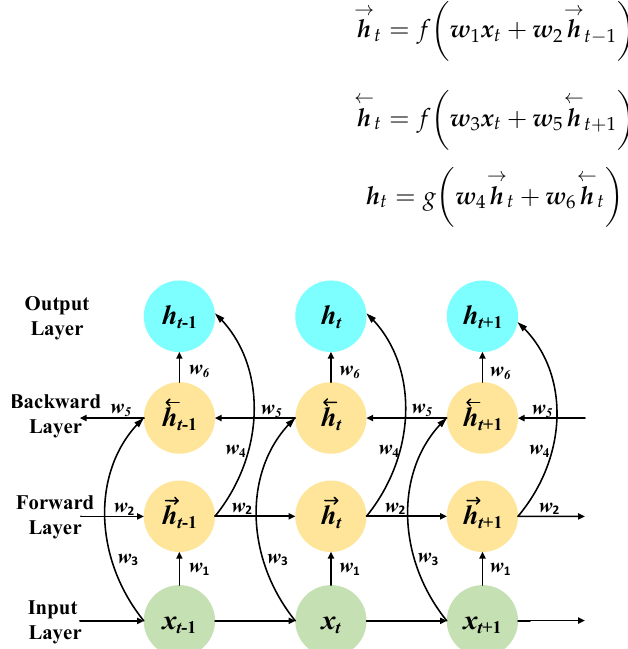
Figure 10. Bidirectional gated recurrent unit